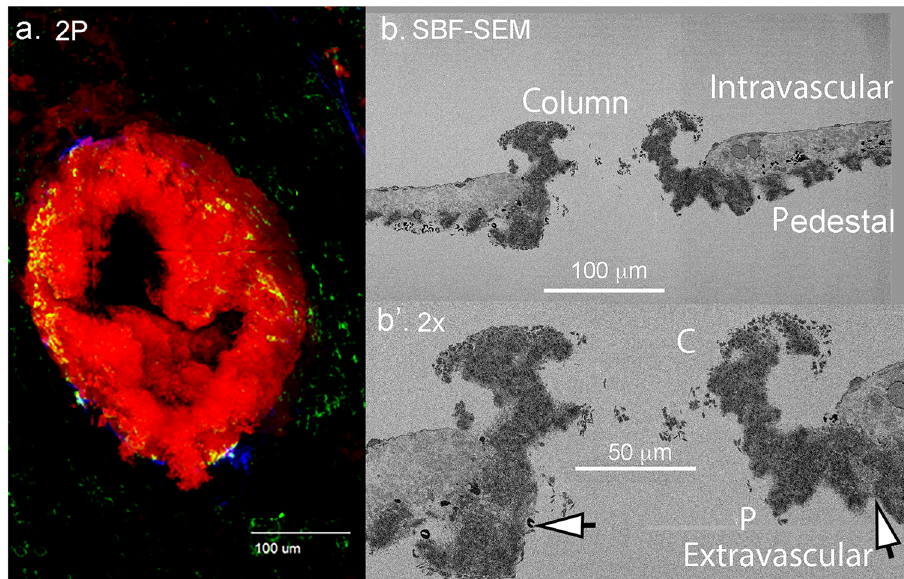
Fig. 4 Early, nucleated platelet accumulation as revealed by 2P and SBF-SEM imaging of 1 min post-puncture thrombi. a 2P, light microscope imaging of the thrombus, maximum intensity projection. Red, CD41 antibody staining, a marker for platelet accumulation; green: p-selectin antibody staining, a marker for α -granule fusion with the platelet plasma membrane; blue, fi brin antibody staining, a marker for what is principally extravascular accumulation of fi brin (see 14 ). b / b ’ SBF-SEM visualization, 20 nm raw XY pixel size, one of a series of images taken every 20 μ m across the forming thrombus. The intravascular lumen of the mouse jugular vein is to the top and the extravascular side of the vessel wall is to the bottom. The vein is lined by a layer of endothelial cells and collagen-rich adventitia below in these images. C, columnar platelet aggregate; P, pedestal (apparent nucleated platelet accumulation anchored to vessel wall adventitial layer. Arrows point to lightly staining platelet areas indicative of platelet degranulation. These presumably correspond to mobilized/ exposed p-selectin staining in the 2P image. Electron micrograph slice is parallel to fl ow.